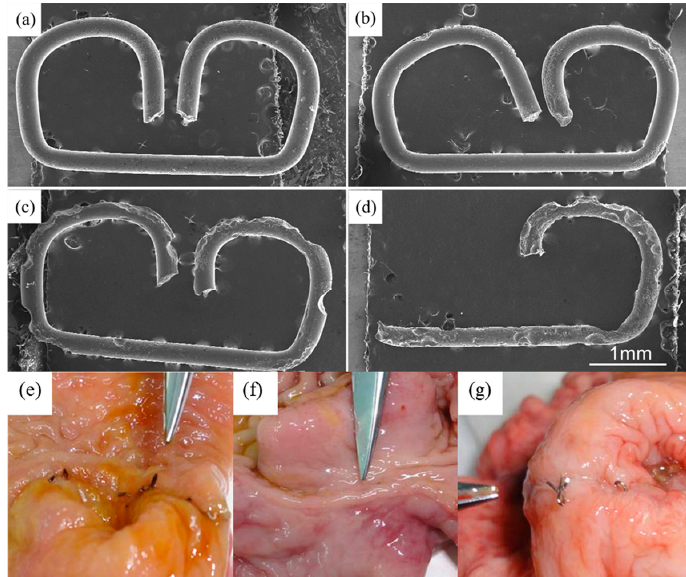
Figure 5. Degradation of magnesium staples under in vitro and in vivo conditions. Optical visualisation of morphology of Mg staples after immersion in simulated body fluid at pH of 4 for ( a ) 3; ( b ) 7; ( c ) 11; and ( d ) 14 days. Photographs of Mg staples implanted into an animal model for ( e ) 7 and ( f ) 90 days; and ( g ) Ti staples implanted for 90 days. Reproduced with permission from [116].